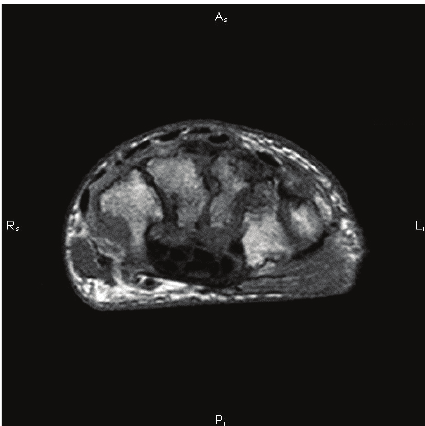
Figure 1: Magnetic resonance imaging of the left wrist before starting antibiotic therapy for Brucella spp. and Mycobacterium bovis . The picture shows increased signal intensity of trabecular bone of all carpal bones, due to marked medullar edema with many erosive areas, most evident in scaphoid and capitate